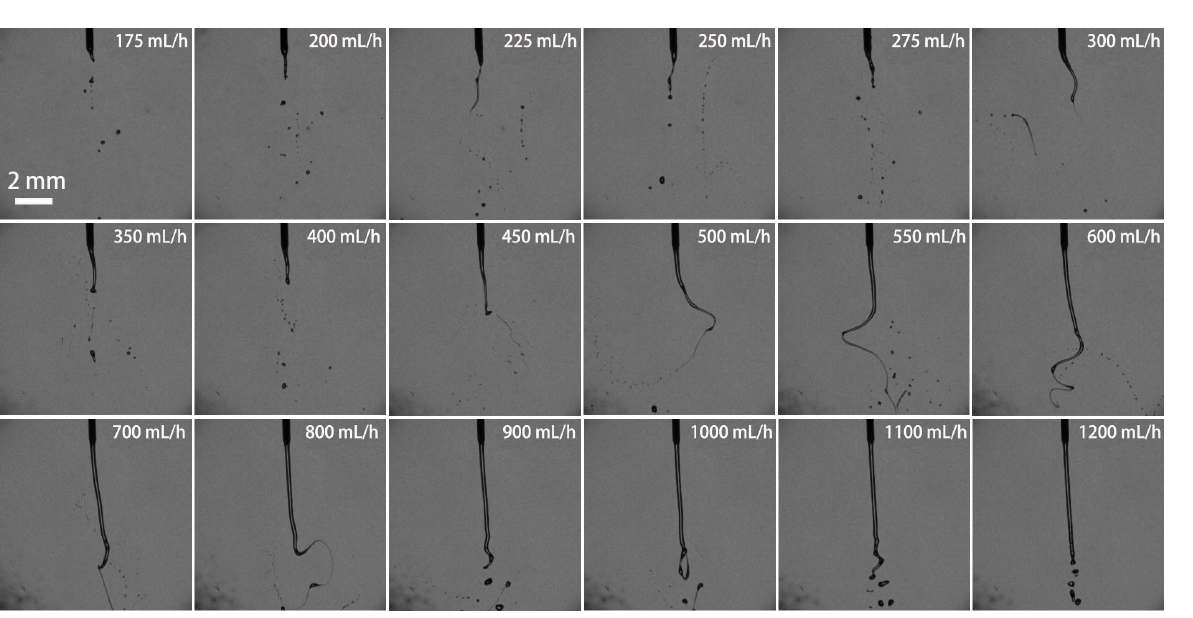
Figure 7. The numbers of breakup droplets at different volume flow rates (21G nozzle, voltage of 28 kV, 35 wt. % concentration).